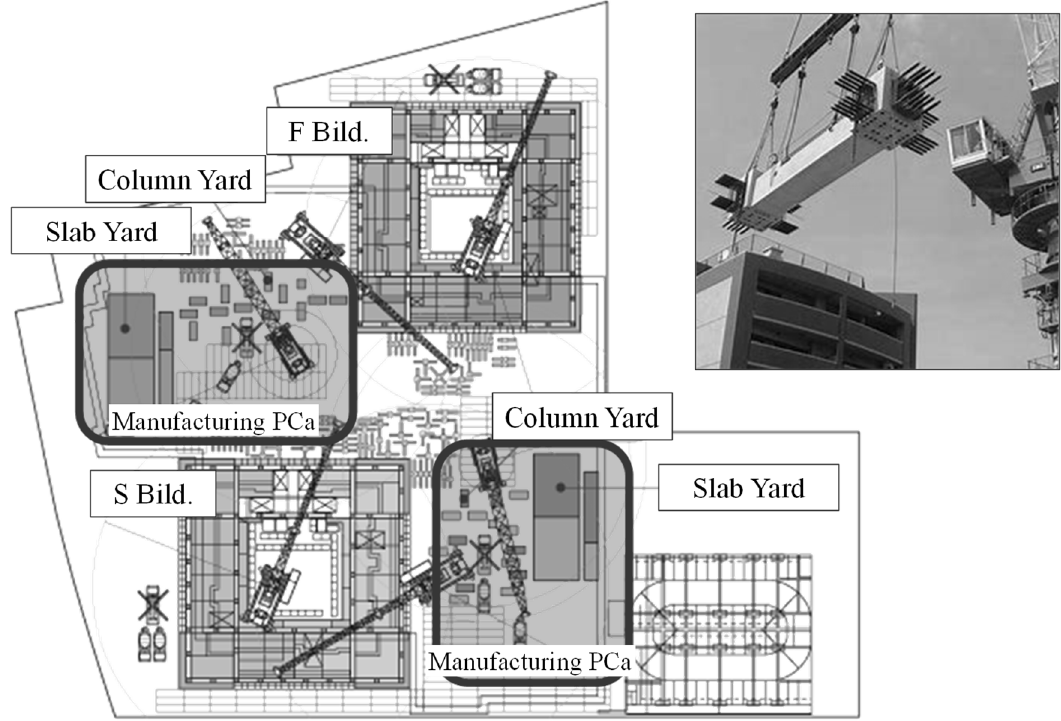
Figure 1. Schematic of site precast concrete (PCa) method.